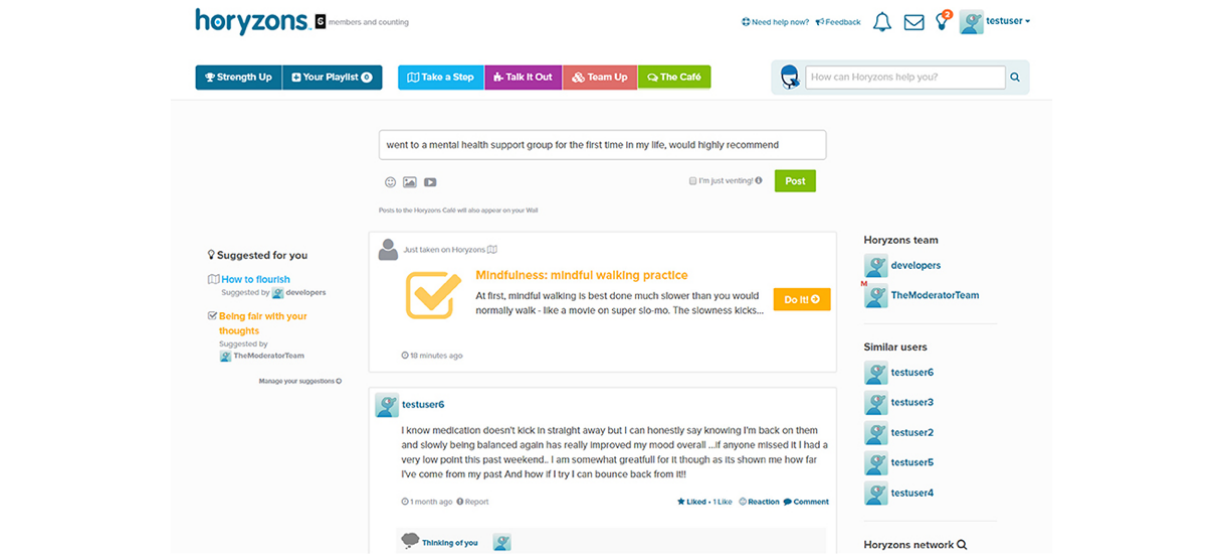
Figure 2. Interactive online social network